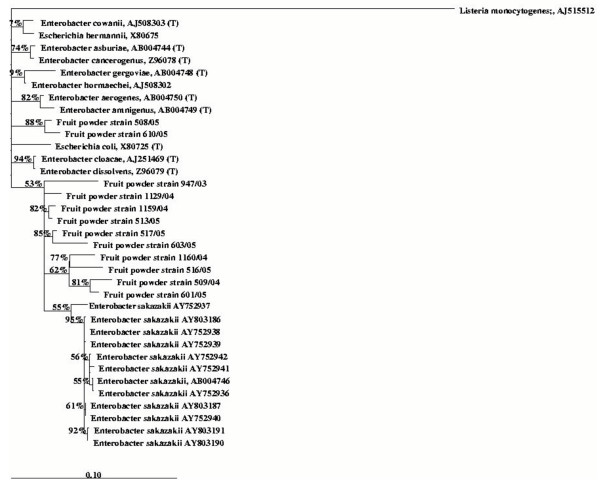
Phylogenetic tree comprising the partial 16S rRNA gene sequences of twelve non-E. sakazakii fruit powder isolates investigated in this study in comparison to a selection of previously sequenced E. sakazakii strains as well as other selected members of the genus Enterobacteriaceae.